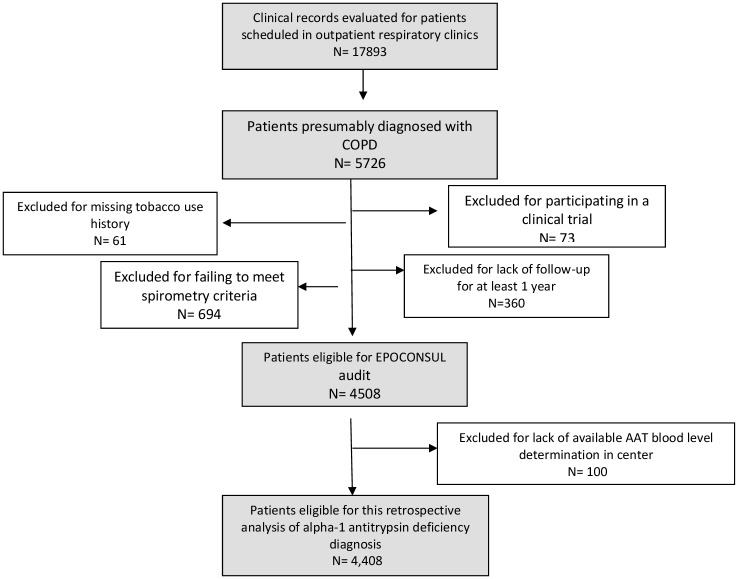
The sampling process is described in a STROBE flow chart.A total of 17,893 clinical records of patients treated in outpatient respiratory clinics were evaluated during the study period and 5,726 clinical records of patients presumably diagnosed with COPD were selected. Of them, 4,508 patients were audited from 59 hospitals, for having all the inclusion criteria and none of the exclusion criteria. A total of 4408 patients audited from 57 hospitals with available AAT blood level determination were included for this retrospective analysis of alpha-1 antitrypsin deficiency diagnosis.